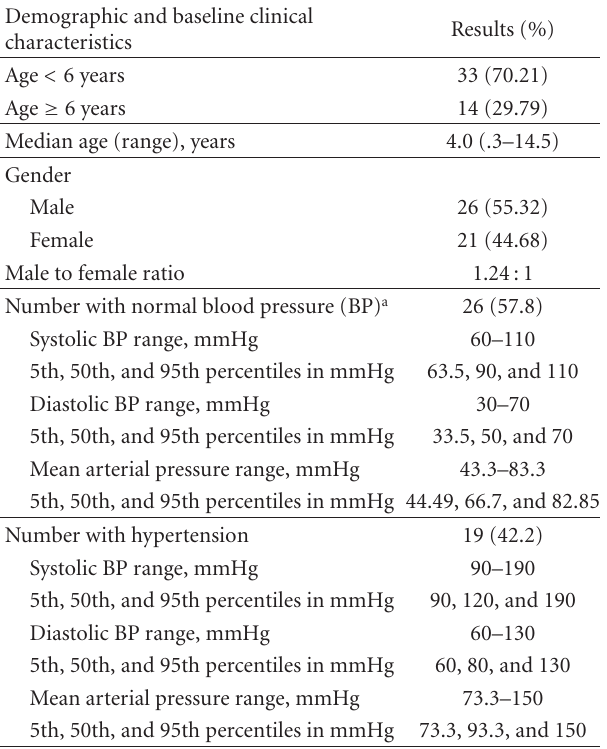
Table 1: Demographic and clinical characteristics of the cardiorenal syndrome patients ( n = 47).